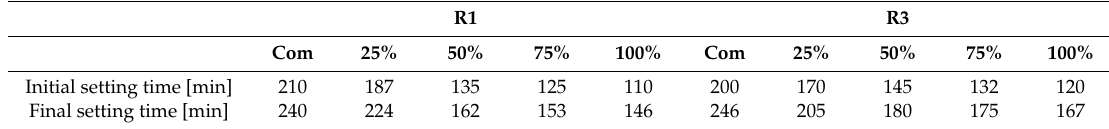
Table 4. Values of the initial and final setting time of Formulas R1 and R3.